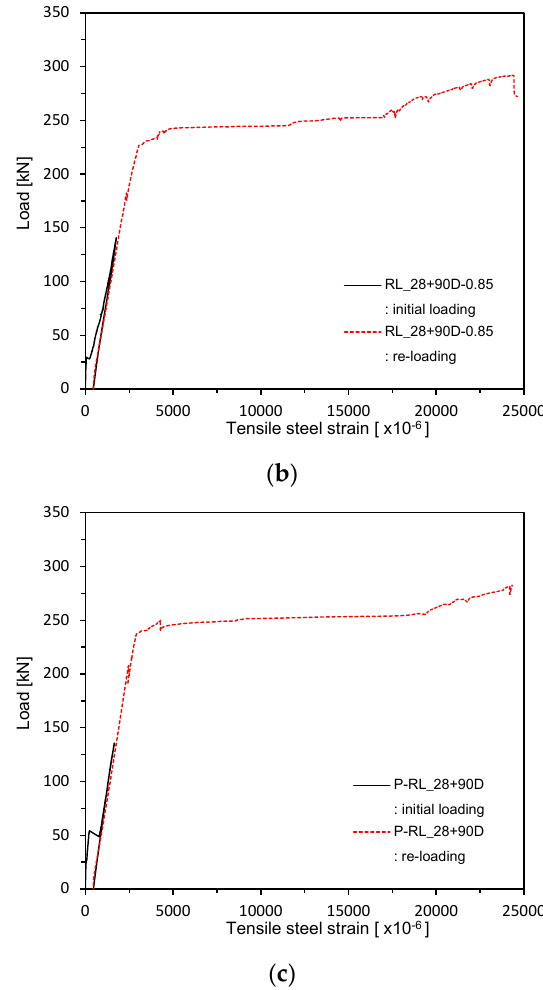
Figure 16. Load–steel reinforcement strain measurement after 28 + 90 days (up to ultimate load after pre-loading and additional 90 days of curing after pre-loading): ( a ) 2.5 series; ( b ) 0.85 series; ( c ) Plain series.